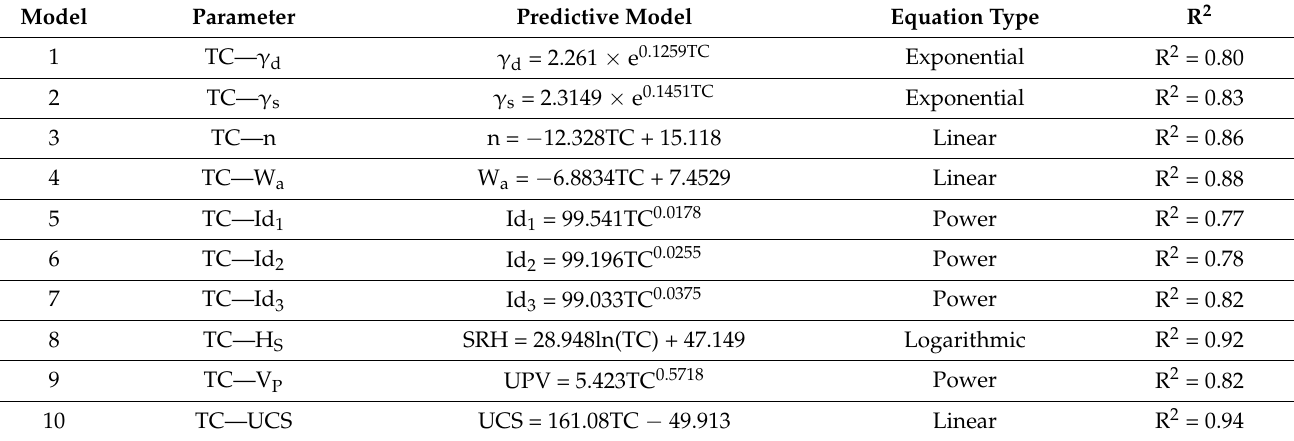
Table 5. Simple regression models for texture coefficient (TC) of the studied